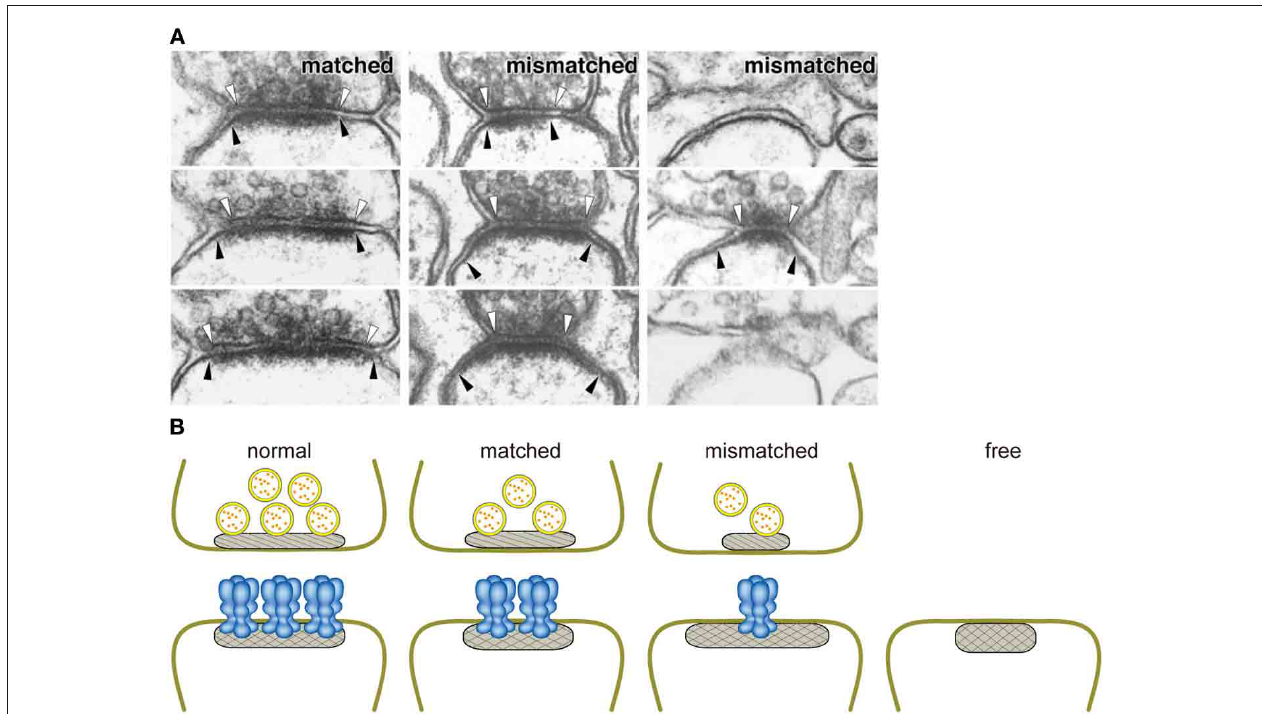
FIGURE 2 | Close relationship between the amount of GluR δ 2 proteinand the size of the active zone. (A) Ablation of GluR δ 2, when induced in the adult brain, resulted in the disruption of synaptic connections with PF terminals in a significant number of PC spines. In addition, some of residual PF-PC synapses show mismatching between pre- and postsynaptic specializations (Takeuchi et al., 2005). White and black arrowheads indicate the edges of active zone and PSD, respectively. (B) Schematic presentation of the relationships between the amount of GluR δ 2 protein and the sizes of presynaptic active zone (hatched) and PSD (cross-hatched). The length of active zone became